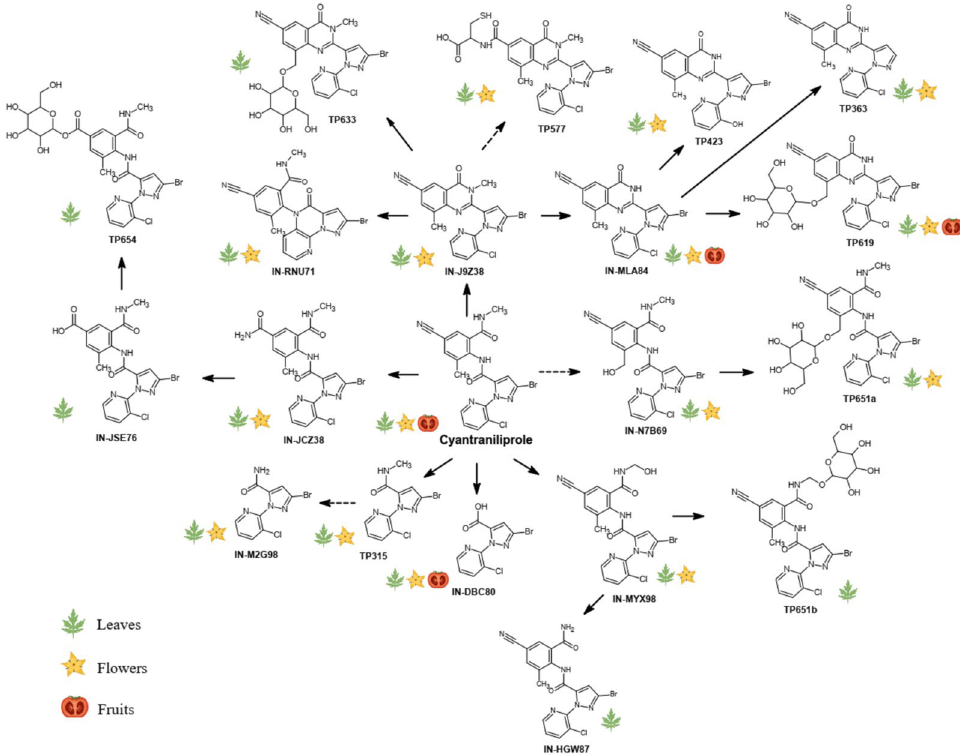
Figure 2. Proposed transformation pathways of cyantraniliprole in tomato plant tissues. Dashed arrows represent the pathways to the metabolites that have previously been reported 32,35,36 , or to the new metabolites identified in this study, in which their presence could not be unambiguously confirmed due to insufficient characteristic product ions acquired during MS 2 fragmentation. The icons depicting leaves, flowers, and fruits indicate the occurrence of cyantraniliprole and its metabolites in the respective